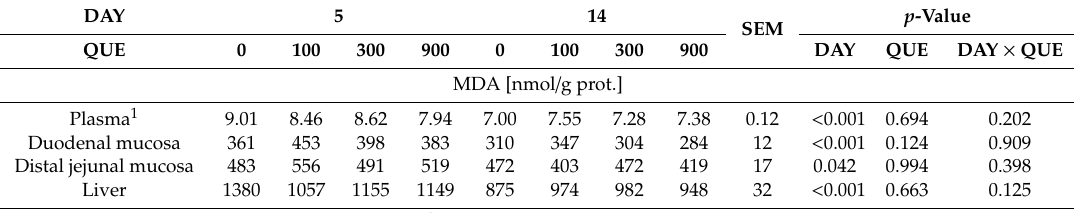
Table 3. The e ff ect of quercetin at a dose of either 0, 100, 300, or 900 mg / kg diet (QUE) fed during the